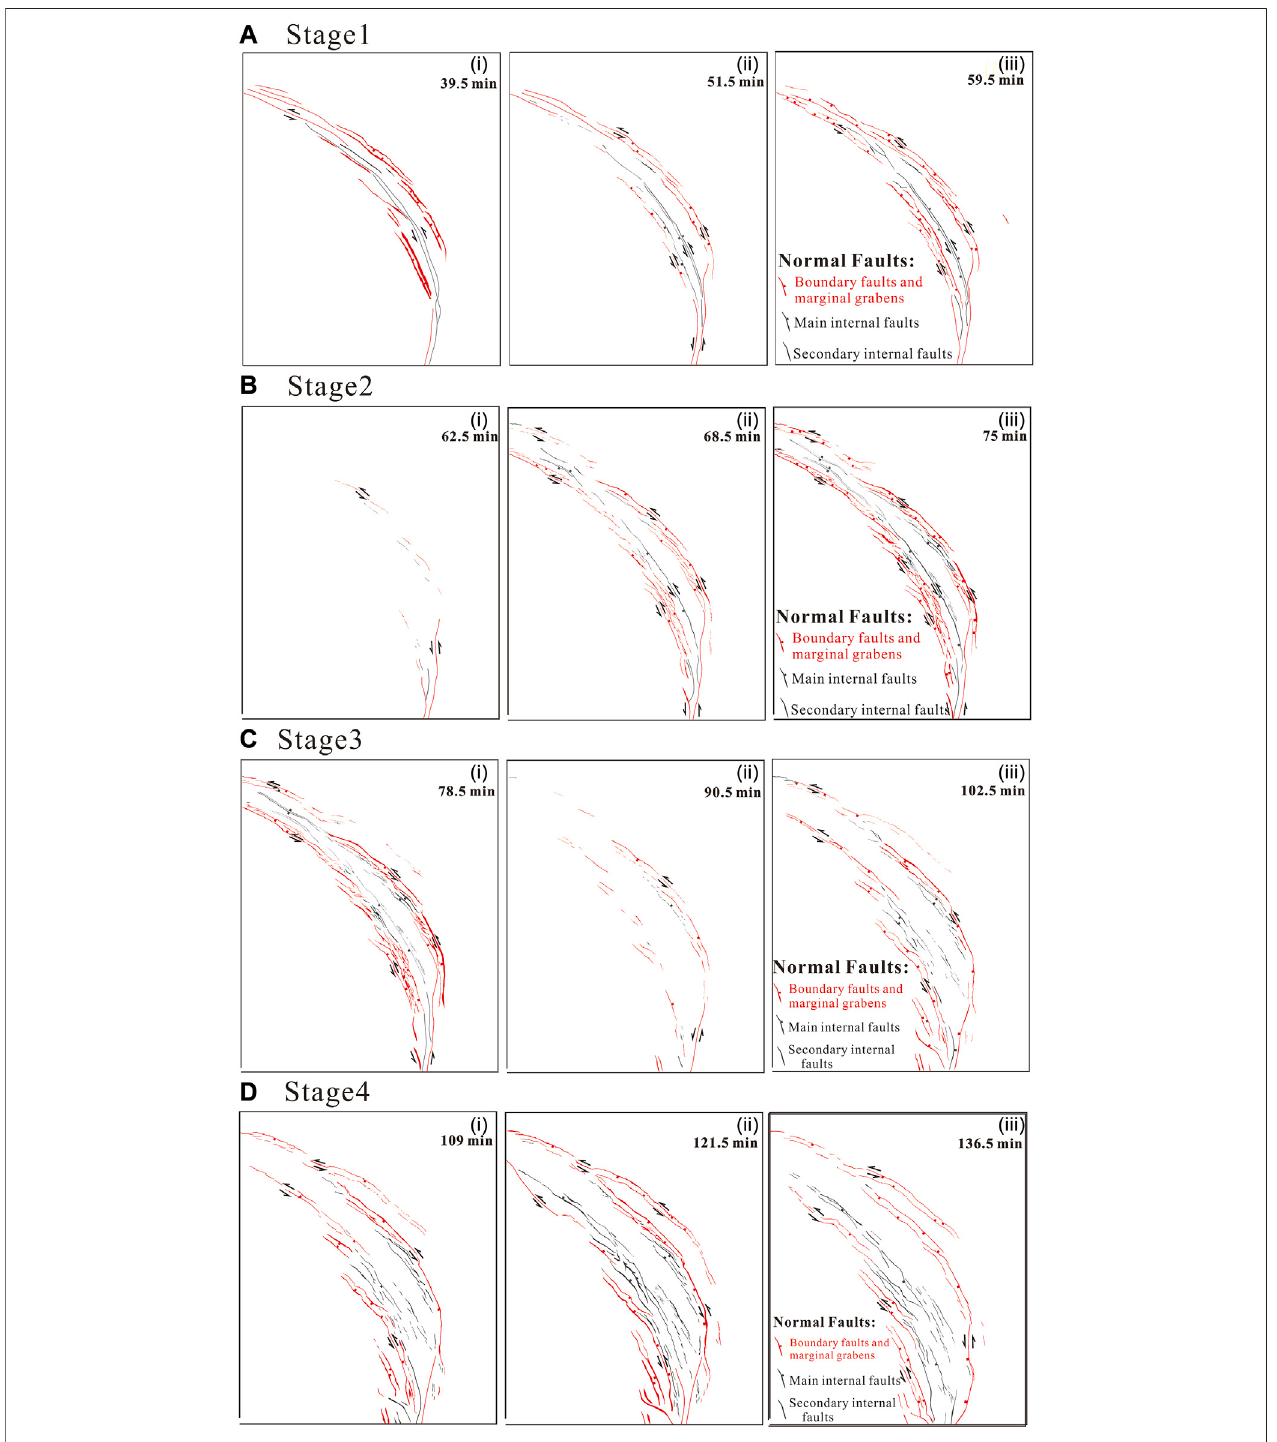
FIGURE 6 | Line drawing of structures for stages 1 (A) , 2 (B) , 3 (C) , and 4 (D) .